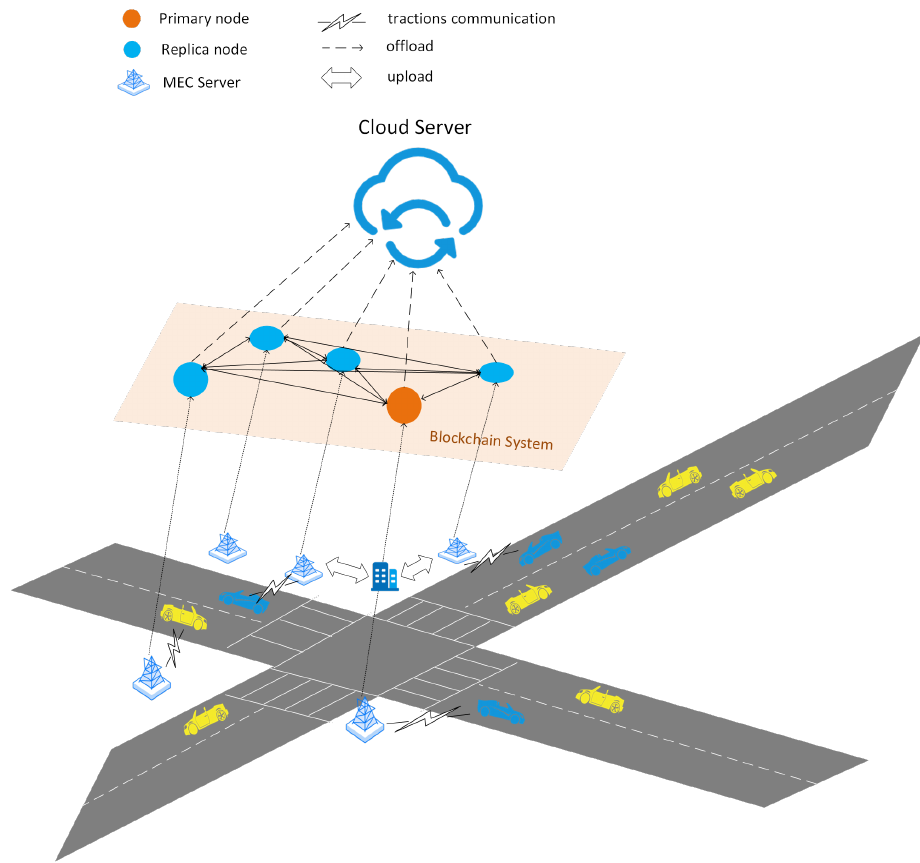
Figure 6. MEC and Blockchain-Enabled Energy Efficient Internet of Vehicles Based on A3C Approach structure in